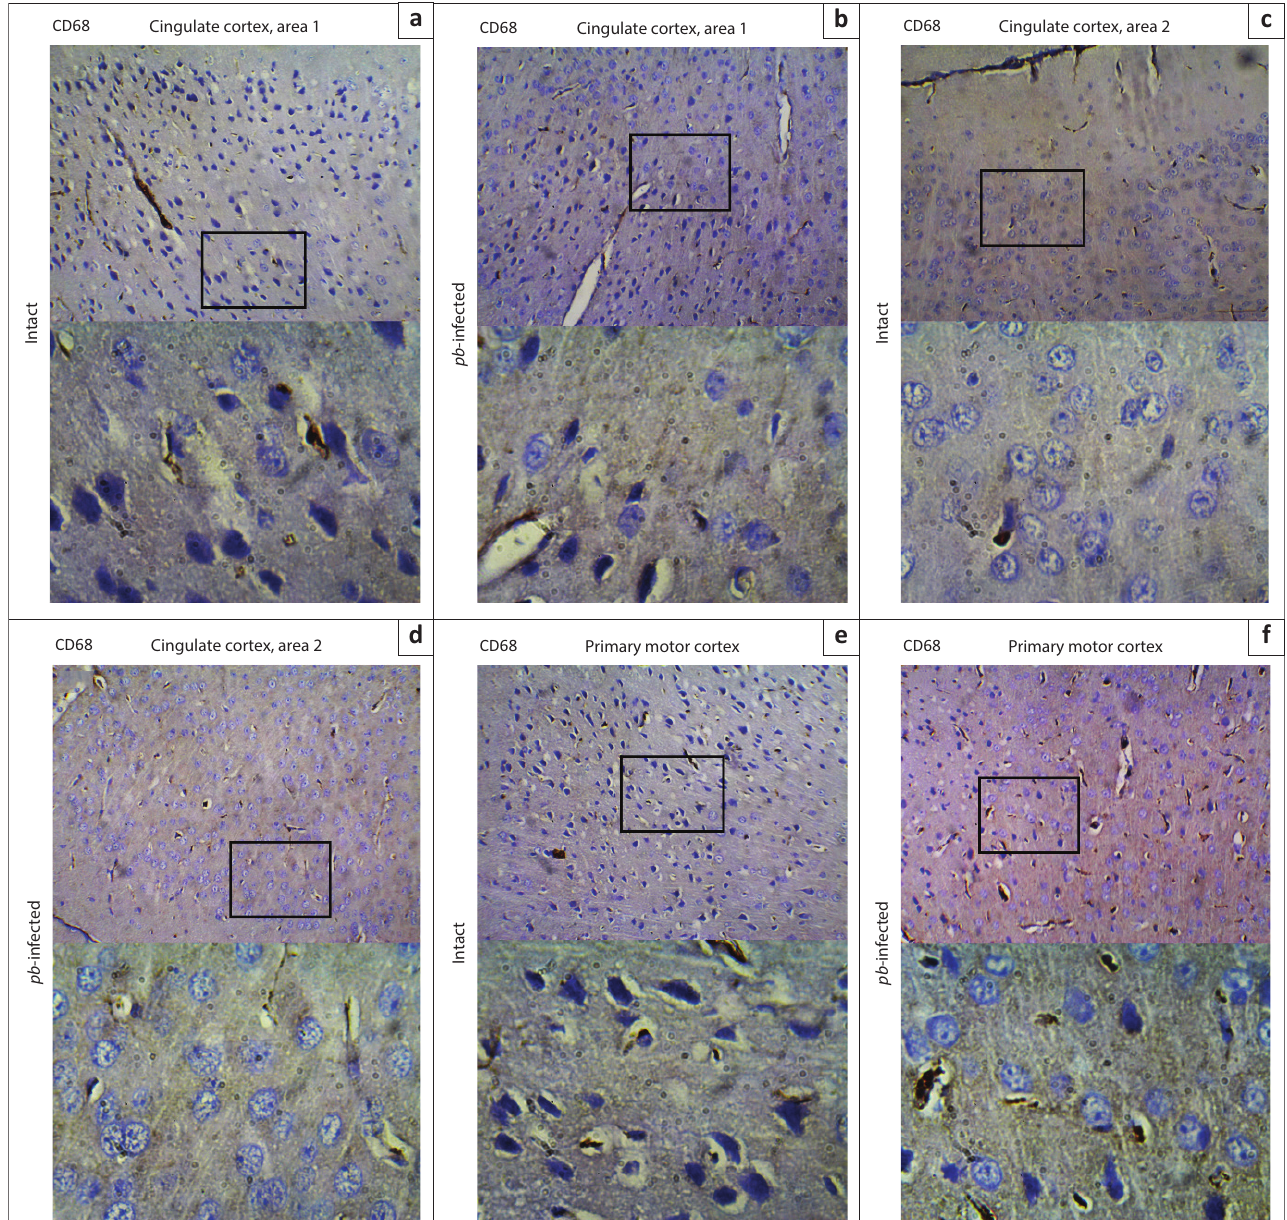
FIGURE 10: Microglial immunostaining within the frontal part of the cerebral cortex. (a) and (b) Anti-CD68 immunostaining sections of cingulate cortex area 1 in intact and Pb -infected mice, respectively. (c) and (d) Staining cingulate cortex area 2 with Anti-CD68 antibody in intact and Pb -Infected mice, respectively. (e) and (f) Respective immunostaining of the primary motor area with Anti-CD68 antibody in intact and Pb -infected mice. There was no immunopositive cell in all the parts of the brain investigated with the marker for cerebral